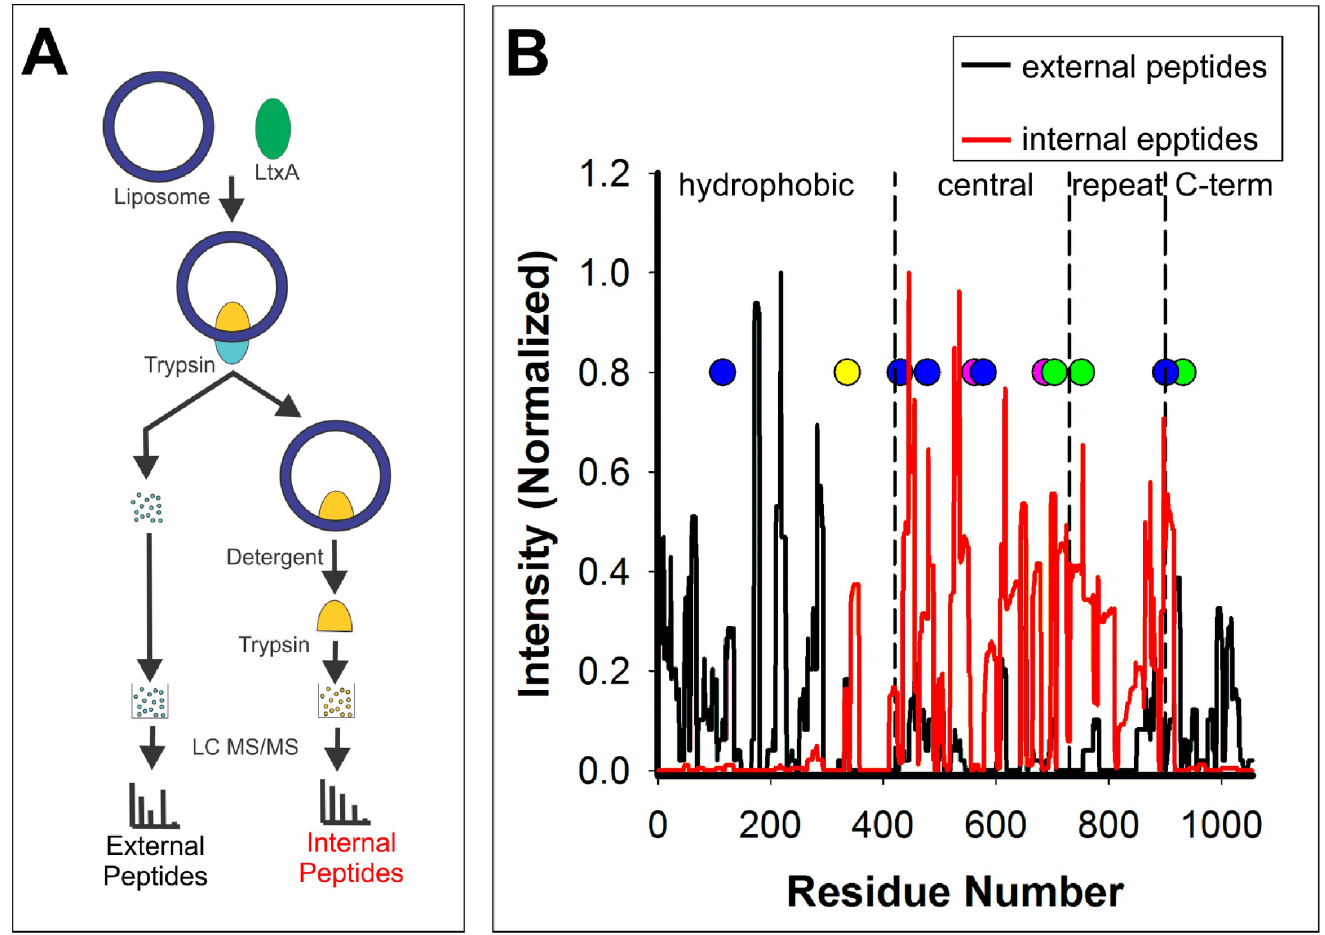
Fig 4. Mass spectrometry analysis of LtxA in solution and in DMPC membranes. Mass spectrometry was used to analyze the results of a trypsin digest experiment. (A) Schematic of the experimental design. LtxA was incubated with DMPC liposomes. The portion of the protein residing outside of the membrane was digested with trypsin; the resulting peptides were separated from the proteoliposome and analyzed by MS. Next, the remaining liposomes, which contain only the domains of LtxA residing inside the membrane were run on an SDS-PAGE gel (which disrupts the liposome); the major protein bands were excised, digested with trypsin and analyzed by MS. (B) Summary of the MS results. Together, the MS results indicate that the hydrophobic and C-terminal domains of LtxA reside outside of the membrane (black), while the central and repeat domains reside within the liposome (red). In each MS plot, the cholesterol-binding motif (yellow), acylation sites (pink), tryptophan residues (blue), and mAb epitopes (green) are marked.